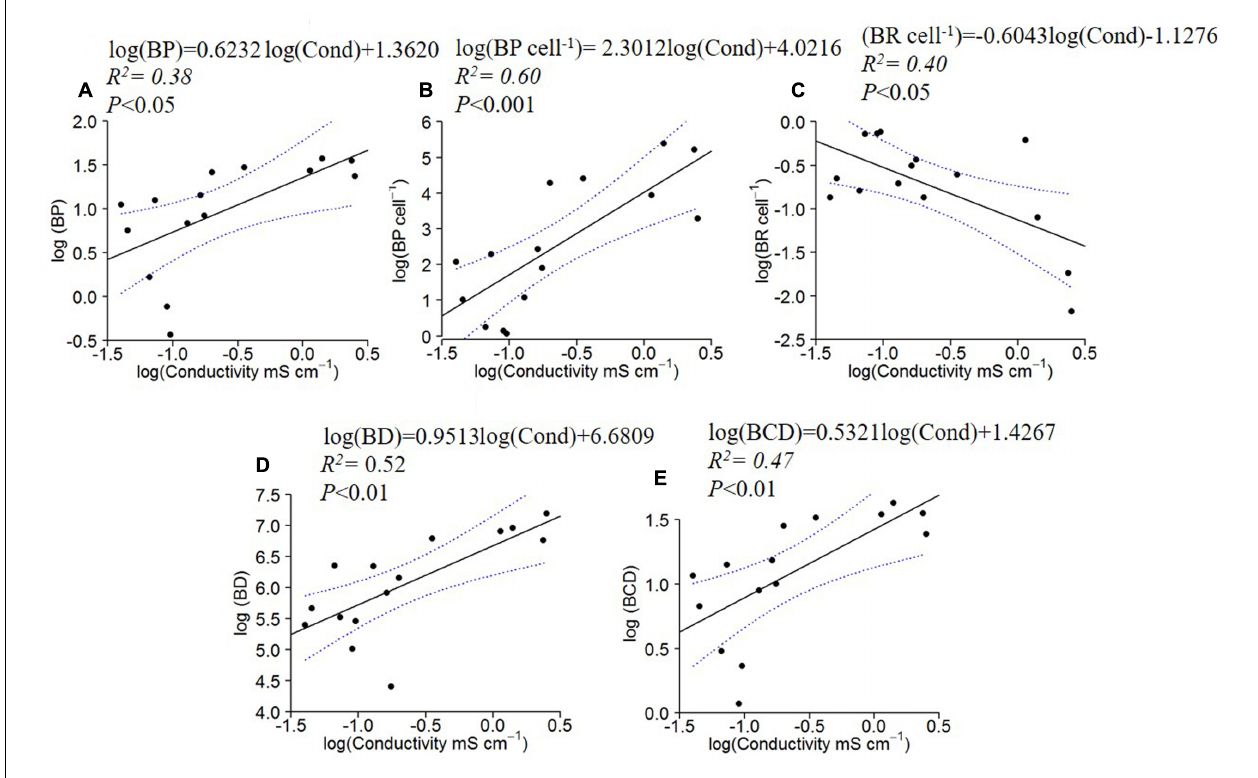
FIGURE 4 | Log 10 linear regressions of bacterial production (BP; A ), specific bacterial production (B) and specific bacterial respiration (C) , bacterial density (BD; D ) and carbon demand (BCD; E ) against specific conductivity. The regression fit is indicated by black solid lines and 95% confidence intervals by blue dotted